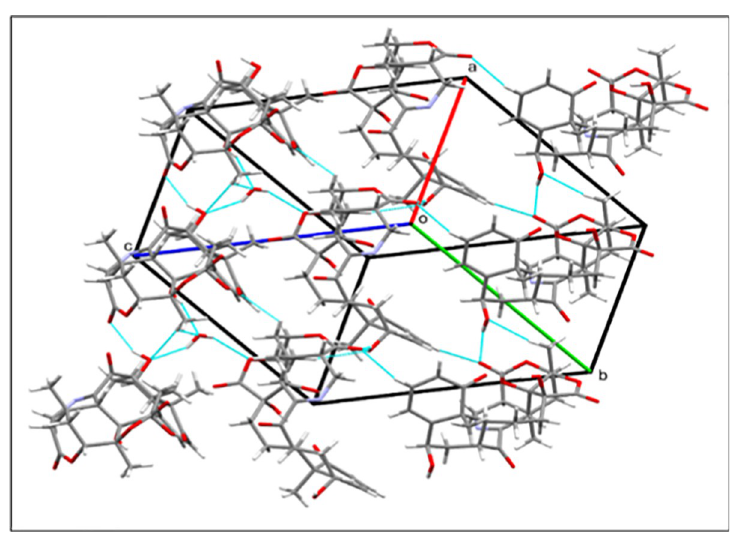
Fig 4. Crystal packing diagram of compound 1.